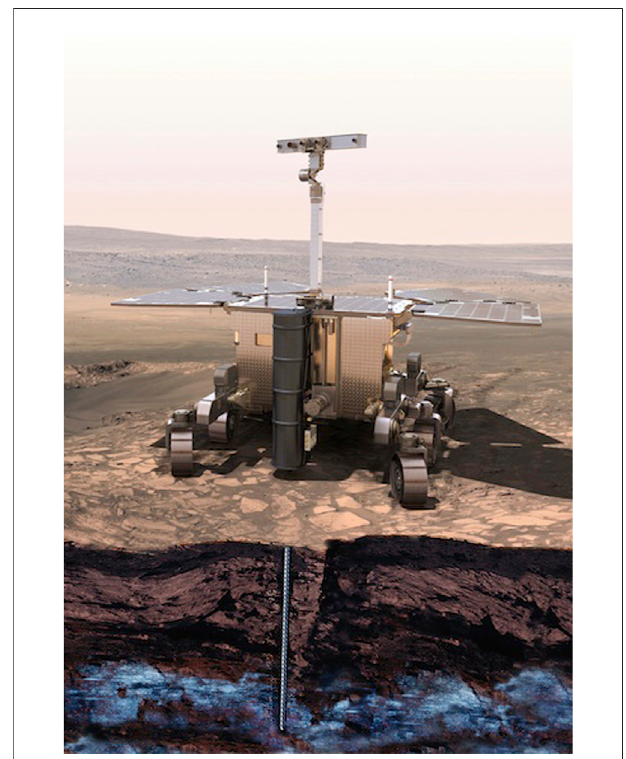
FIGURE 1 | ExoMars rover Rosalind Franklin developed by ESA hosting a suite of analytical instruments dedicated to geochemistry research (credit: